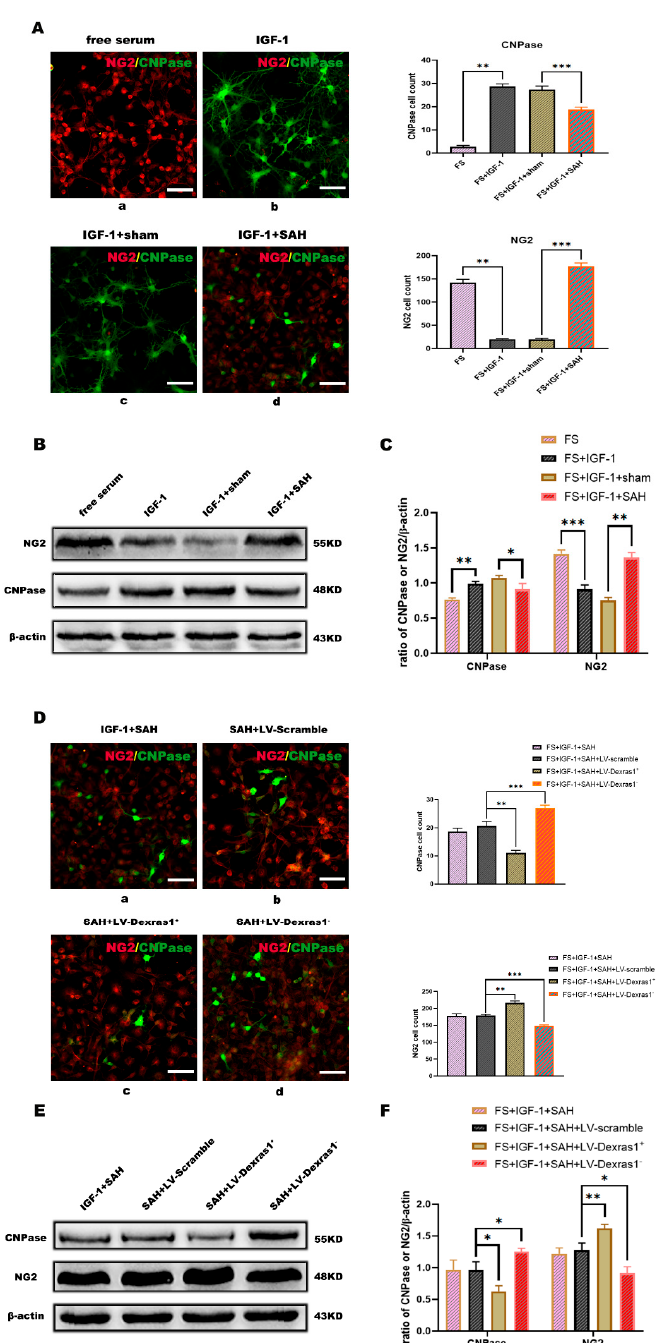
Figure 6. ( A ) Immunofluorescence detection of oligodendrocyte precursor cell differentiation after in vitro subarachnoid hemorrhage, serum-free culture of oligodendrocyte cell line (a), IGF − 1